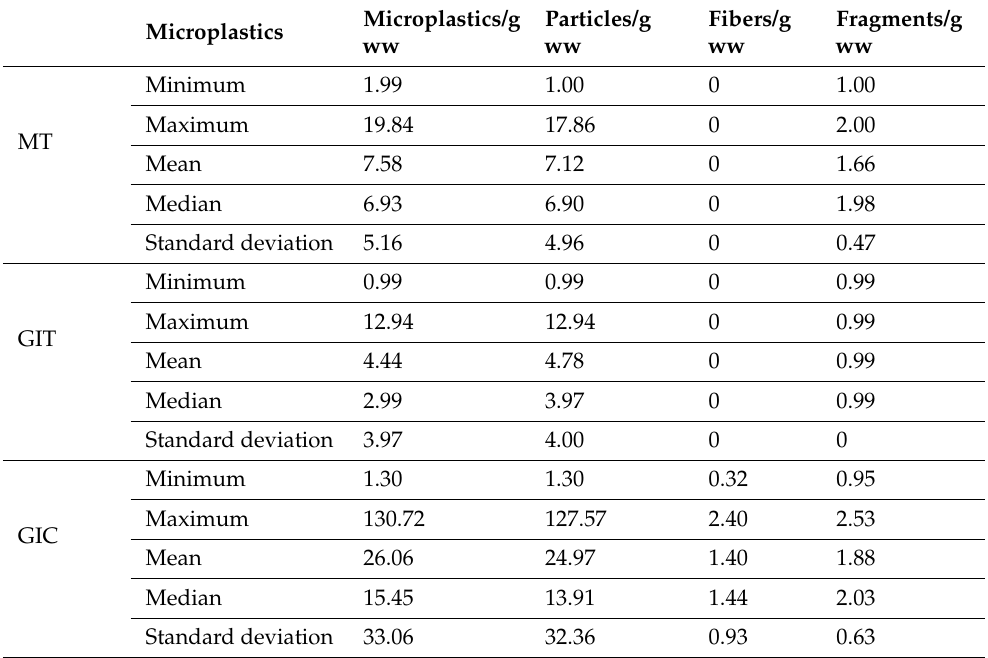
Table 3. Concentration of microplastics in Chondrostoma nasus individuals; gastrointestinal tissue (GIT), the gastrointestinal content (GIC) and muscle tissue